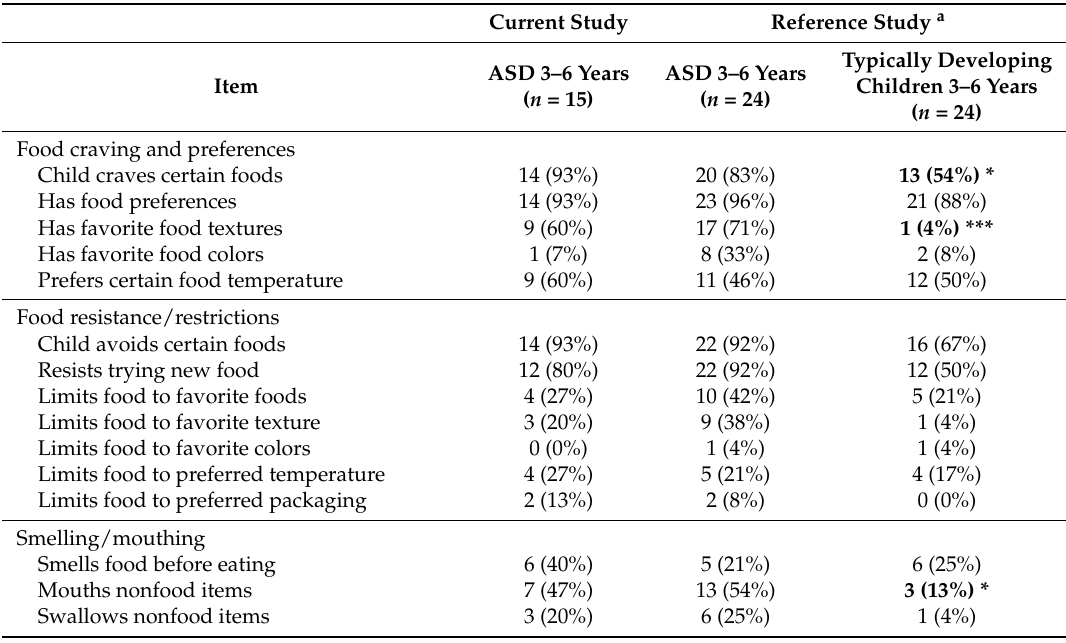
Table 7. Food preferences and